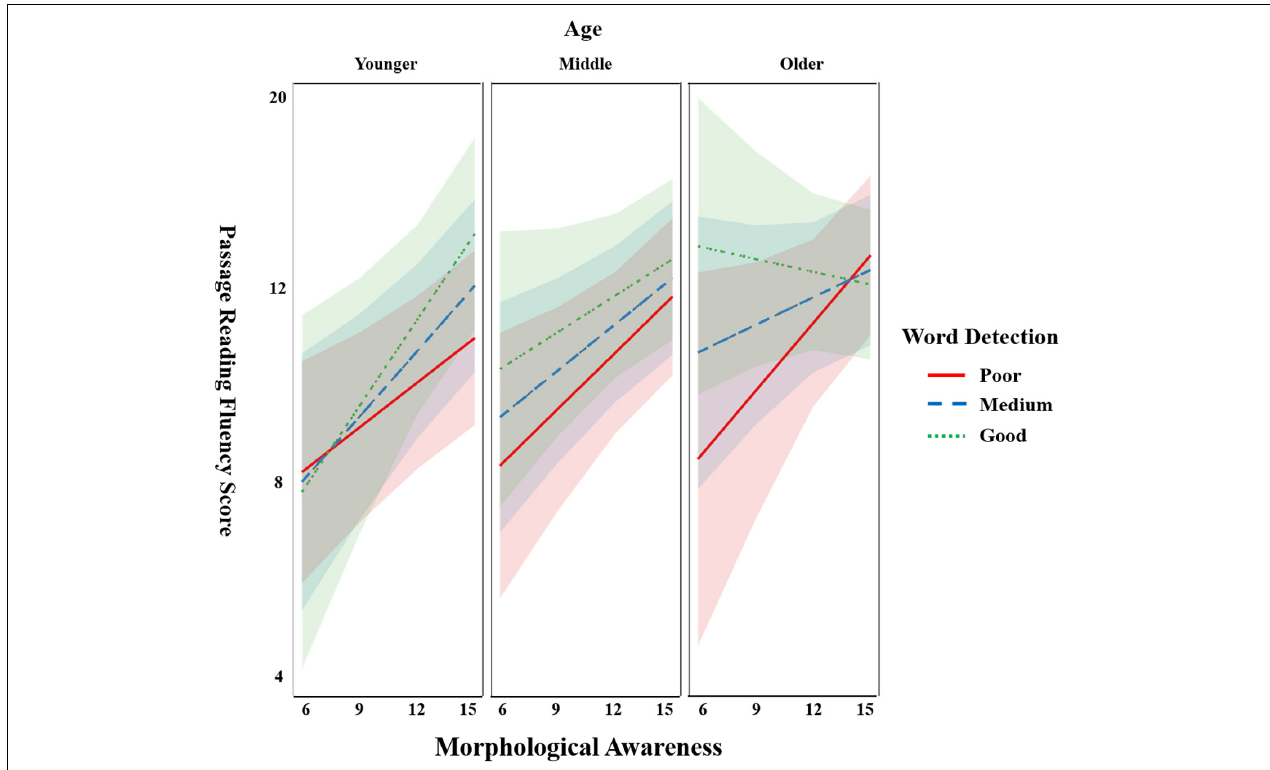
FIGURE 3 | The interaction effect of word detection, morphological awareness (MA), and age on reading fluency. Figure 3 was developed based on the results of a linear mixed model (LMM), in which age and word detection were entered as continuous factors. To display the results visually, three representative ranges of age (i.e., Younger, Middle, and Older) and of word detection (i.e., Poor, Medium, and Good) were selected according to their corresponding Mean (age: 11.76; word detection: 0.26) and SD (age: 2.25; word detection: 0.12). Younger age/Poor word detection = smaller than (Mean–1 SD ); Middle age/Medium word detection = between (Mean–1 SD ) and (Mean + 1 SD ); and Older age/Good word detection = larger than (Mean + 1 SD